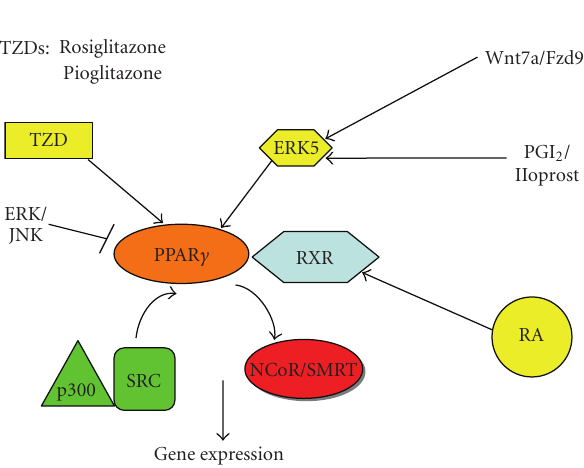
Figure 1: Activation pathways for PPAR γ . PPAR γ forms a heterodimer with the retinoic acid X receptor (RXR). Activation can occur by thiazolidinidiones (TZD) such as rosiglitazone or pioglitazone directly binding to the ligand-binding domain. This results in the dissociation of corepressors such as NCor and SMRT, and the binding of coactivators such as p300 and Src, mediating activation of transcription. In lung cancer cells, binding of Wnt7a to its cognate receptor Fzd9 leads to activation of ERK5, which presumably directly binds to the hinge region of PPAR γ mediating activation. Prostacyclin (PGI) and analogs such as iloprost can also lead to PPAR γ activation, and this may involve ERK5 activation. Conversely, activation of the ERK or JNK family of MAP kinases can inhibit PPAR γ activation; this is mediated through direct phosphorylation of the molecule which alters the ligand binding a ffi nity. Finally, activation of PPAR γ /RXR heterodimers may be activated through retinoic acid (RA) binding to